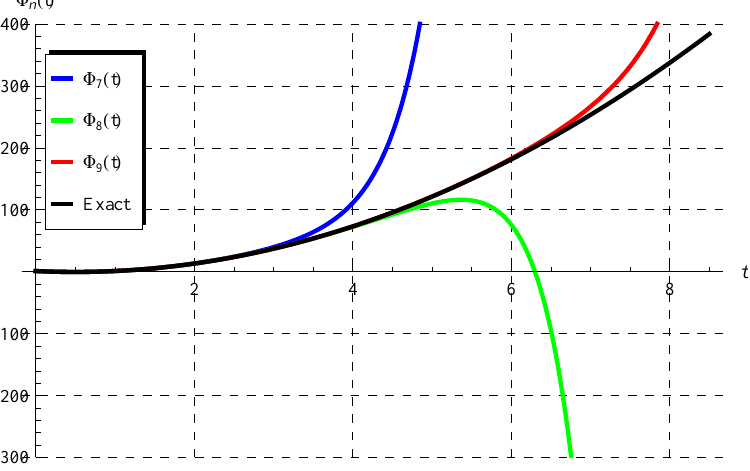
Figure 4. Comparisons between the approximate solutions Φ n ( t ) , n = 7,8,9 in Equation (67) and the exact solution in Equation (69) at a = 2, b = − 8, c =